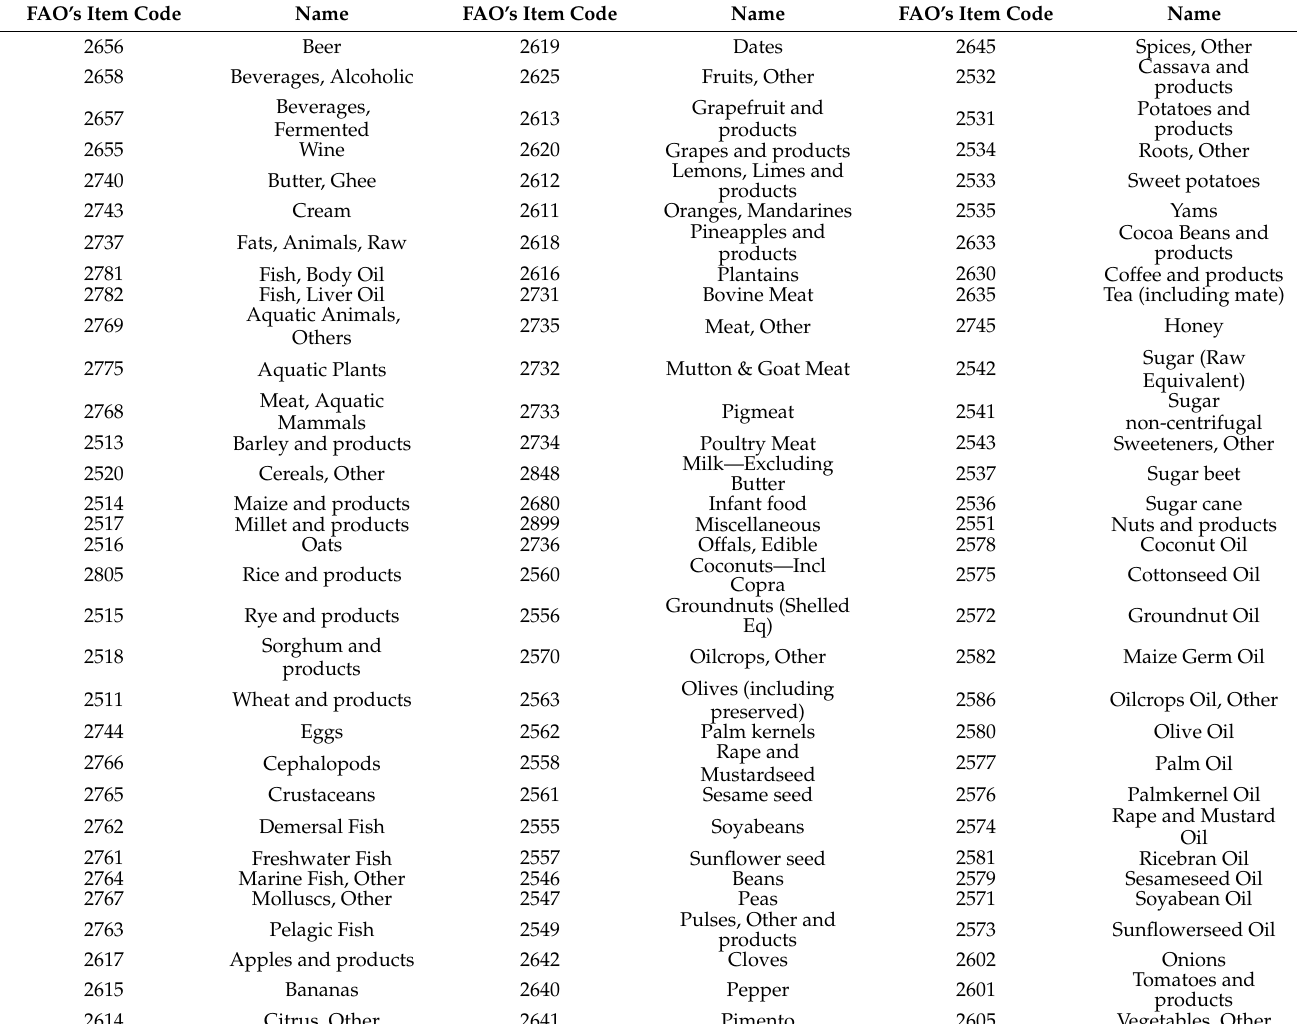
Table A1. The list of products that have been considered for edible energy production with their corresponding FAO’s item